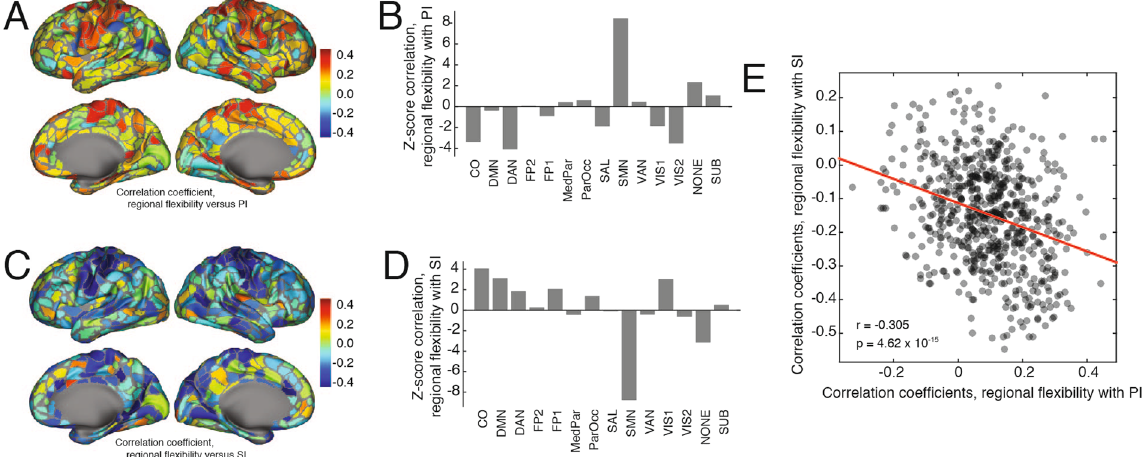
Figure 4. Relationship of regional flexibility with positivity and surprise indices. ( A ) Topographic representation of the correlation coefficient of each region’s flexibility score with the positivity index. ( B ) Regional correlations grouped by system. Panels ( C,D ) are identical to ( A,B ), but replace the positivity index with the surprise index. ( E ) Regional correlation coefficients – of flexibility with positivity and flexibility with surprise – plotted against one another.